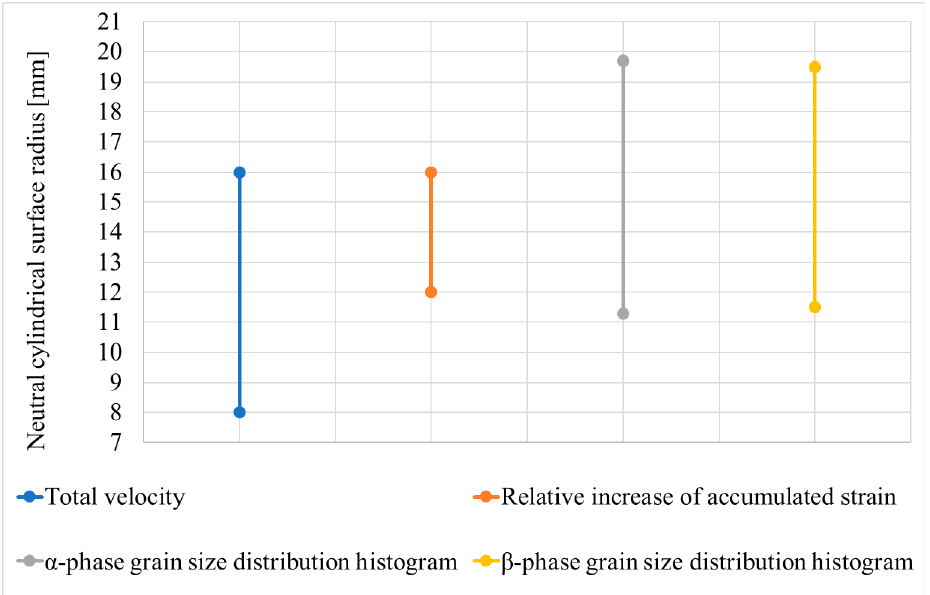
Figure 10. Limits containing the neutral cylindrical surface radius, which were calculated using the computer simulation and the experimental radial shear rolling.